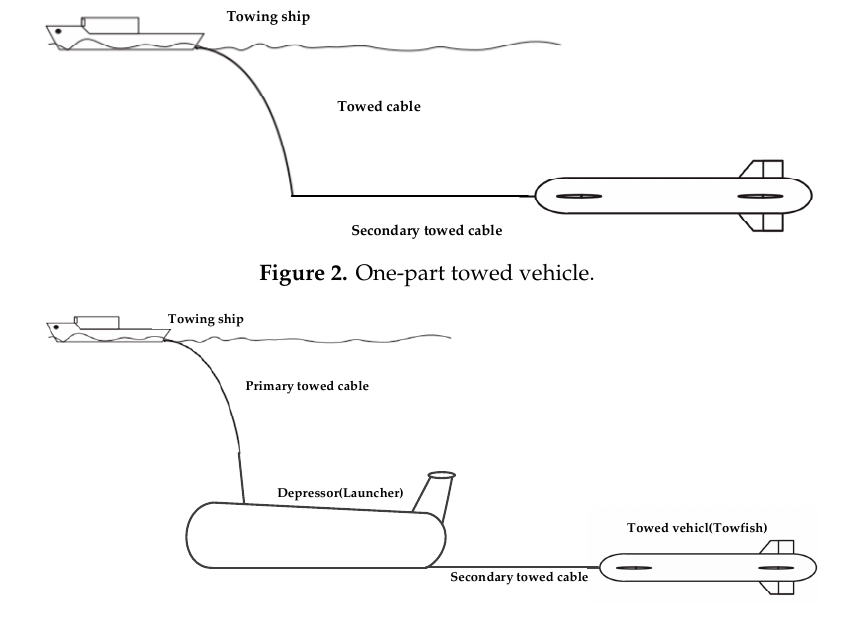
Figure 3. Two-part towed vehicles.